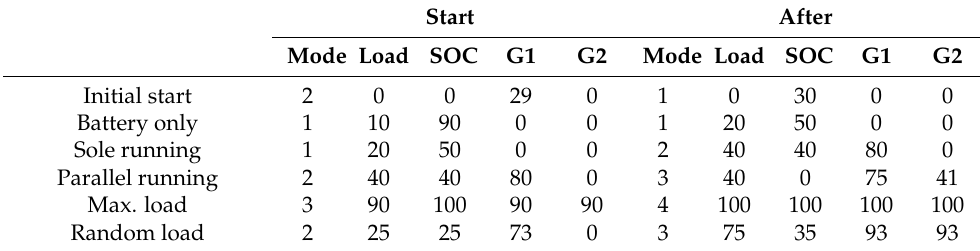
Table 4. Load environments for testing proposed generator–battery hybrid